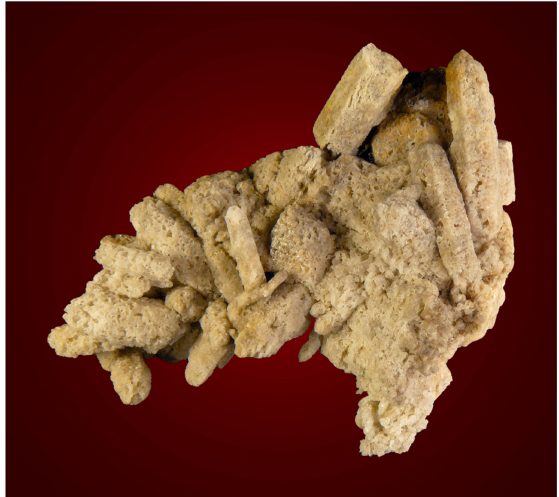
Figure 19. Spongy quartz, Chub Lake prospect. Note voids caused by dissolution of enclosed calcite and prismatic habit of crystals. 8.7 cm. Chamberlain Collection, NYSM 35967.